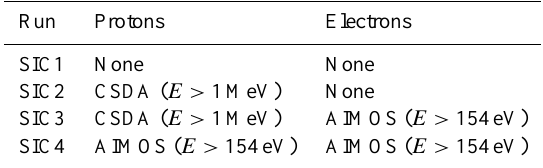
Table 2. Particle ionization rates used in the SIC model runs.